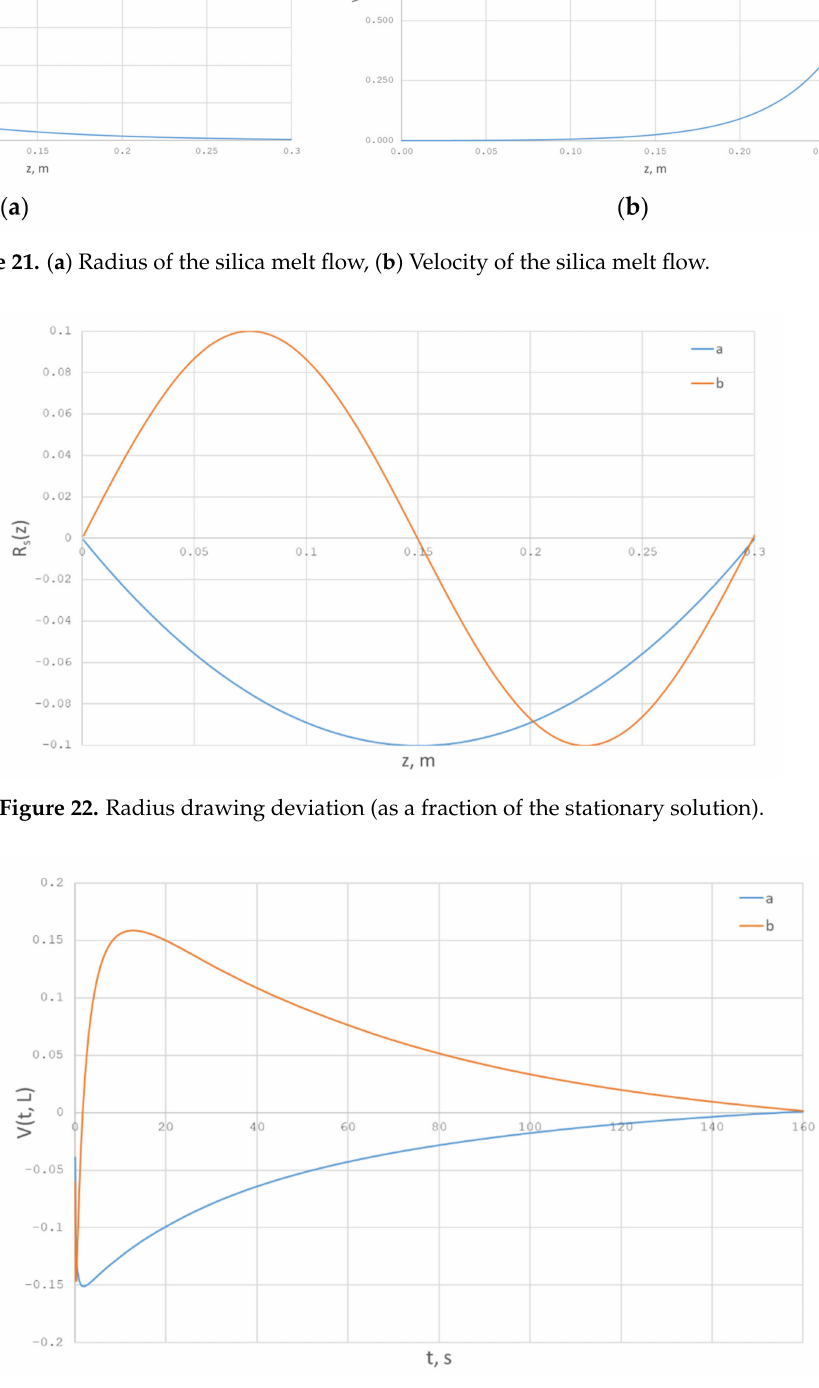
Figure 23. Obtained control